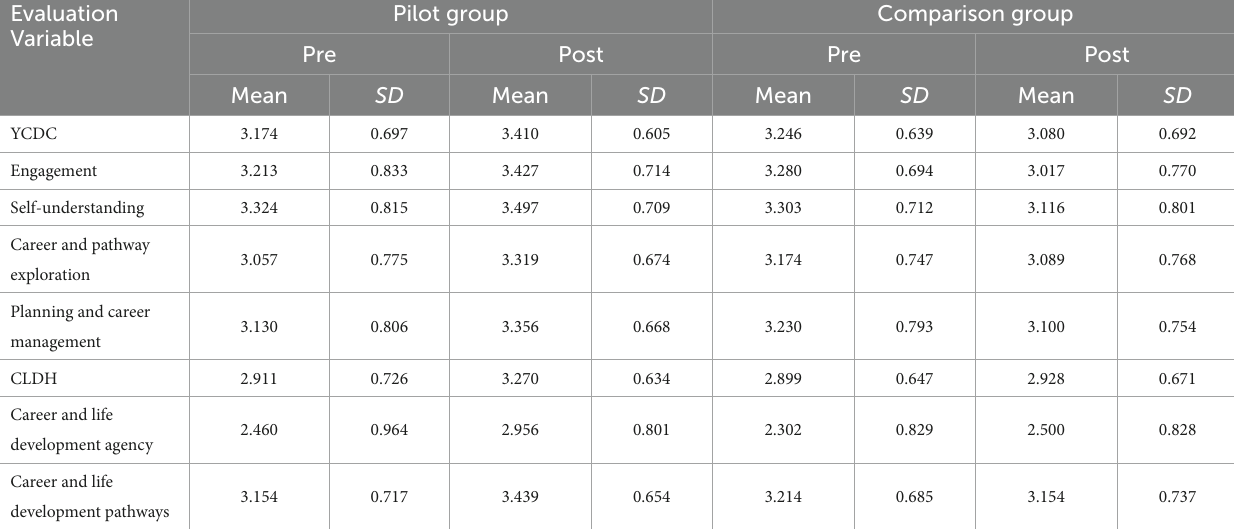
TABLE 4 Means and standard deviations of the main variables pre- and